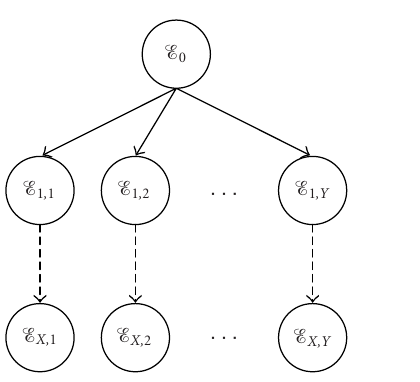
Figure 2: Example of dependency structure of scalable sources.